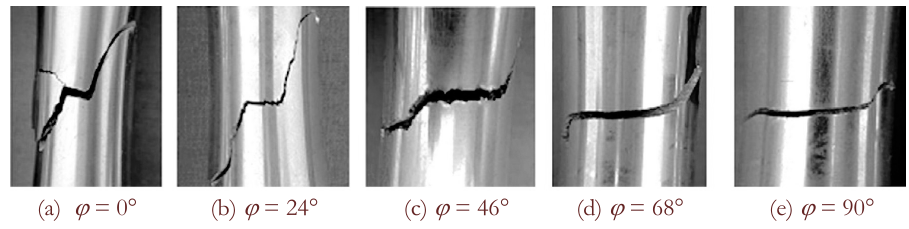
Figure 5: Out-of-phase (  ) fracture appearance for a constant stress amplitude ratio,  3